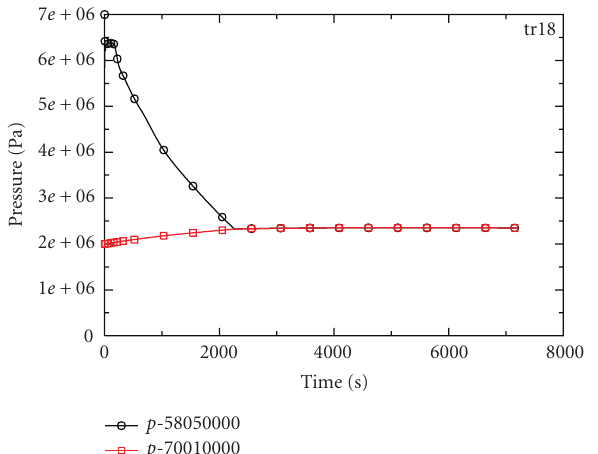
Figure 3: Pressures in the upper plenum and the guard contain- ment.